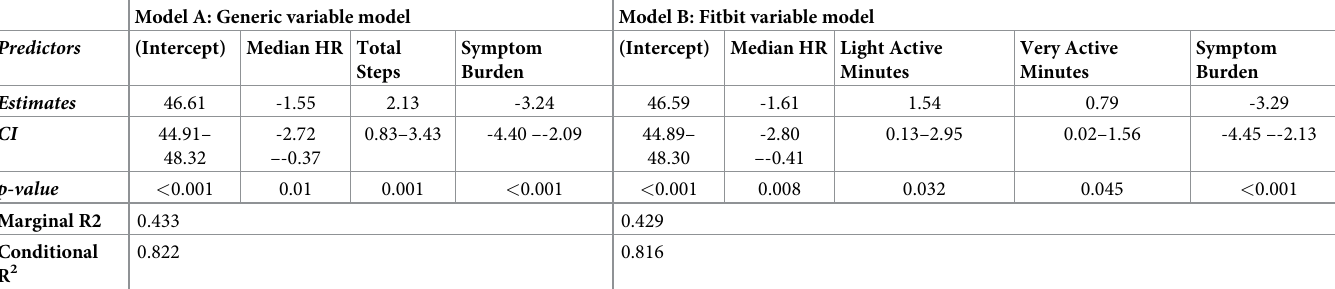
Table 2. Physical function T-score prediction using sensor data and symptom burden. The generic variable model (left) includes variables that should be available from most tracker models while the Fitbit-specific variable model (right) uses Fitbit-specific variables derived from proprietary algorithms. Marginal R 2 values, which con- sider non-patient specific (or fixed) effects, are similar in both models, indicating similar goodness of fit. Conditional R 2 values, which incorporate both patient specific and fixed effects are also similar. Model A: Generic variable